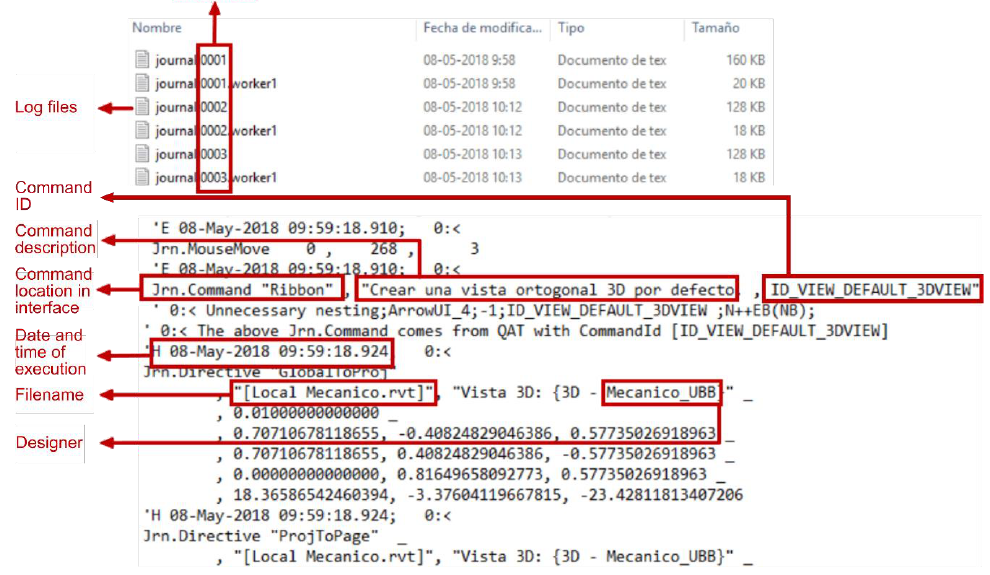
Figure 3. An example of a Building Information Modeling (BIM) log file and its content.